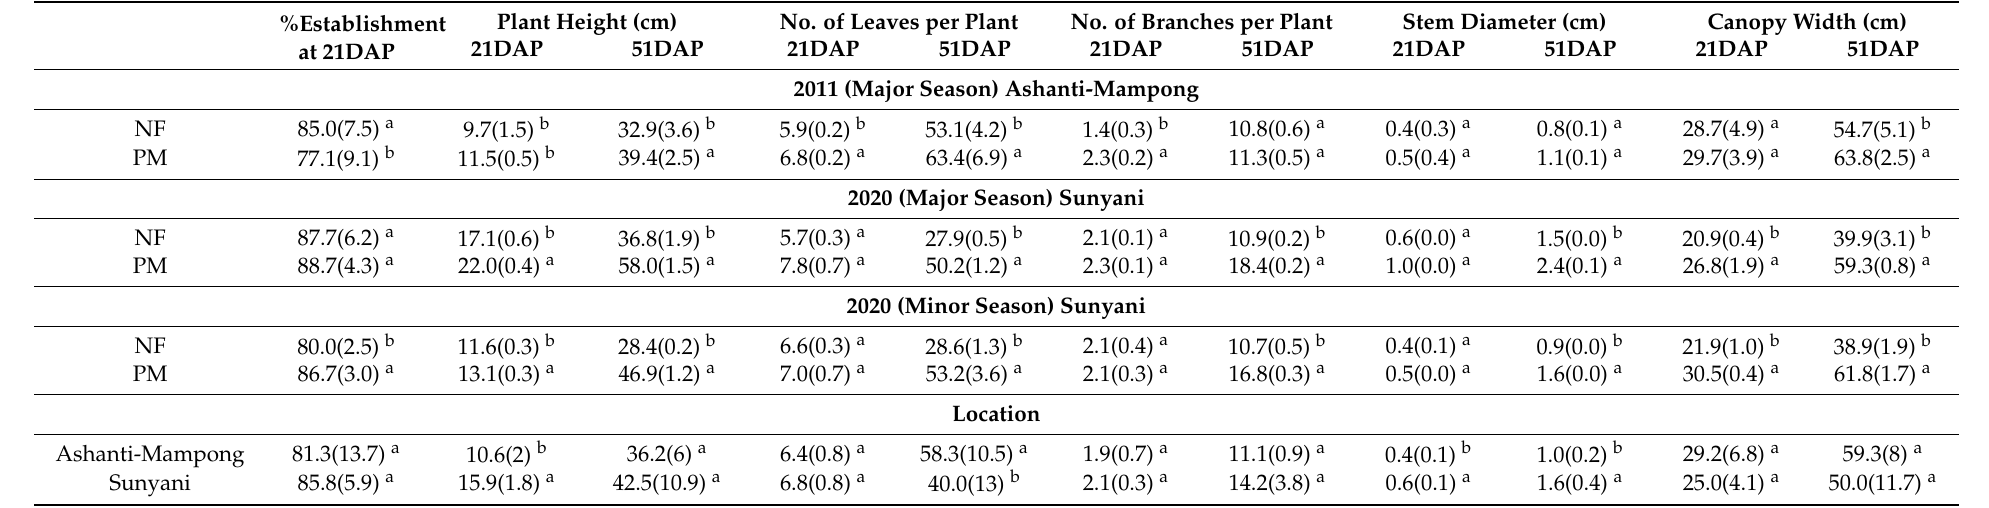
Table 3. Growth performance of garden eggs in a tropical sandy loam soil in Ghana under poultry manure